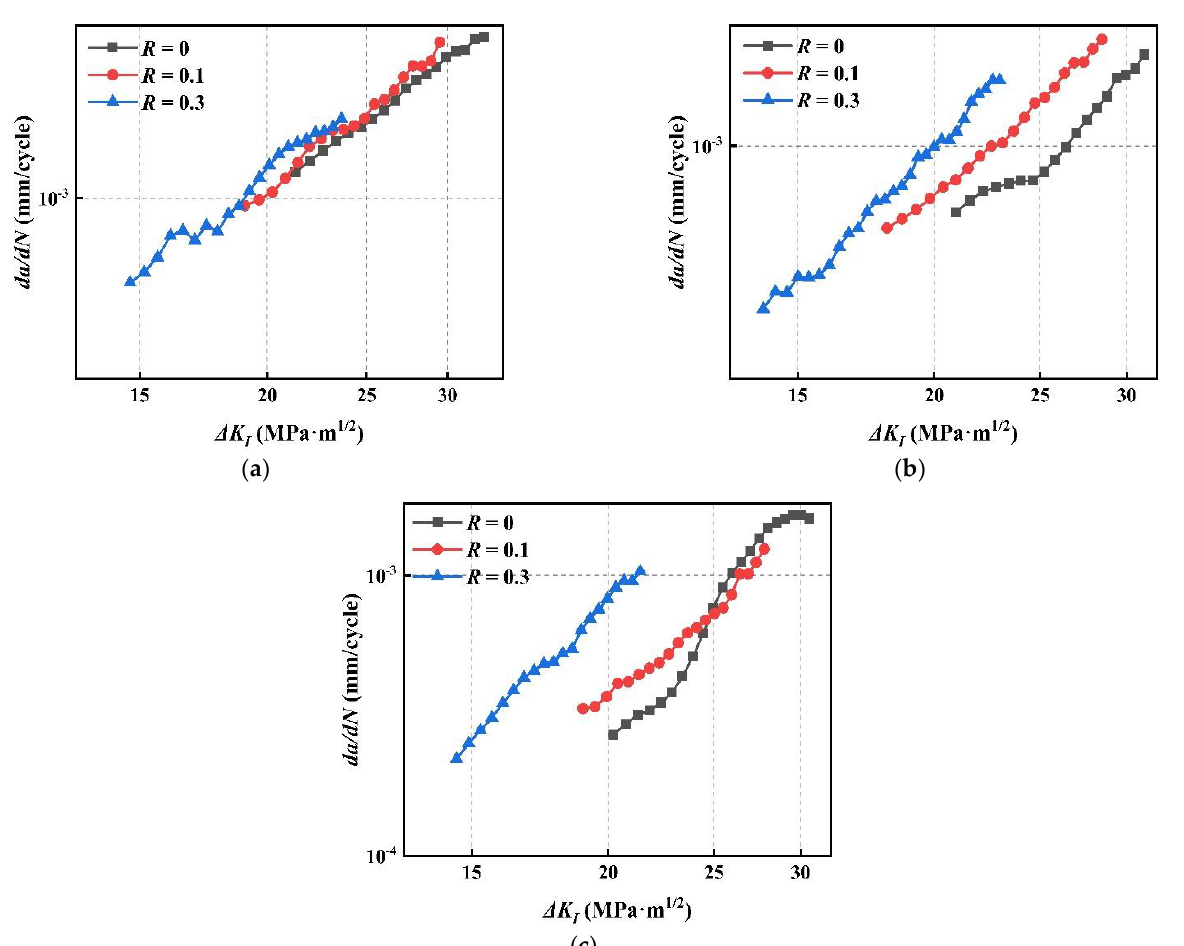
Figure 9. Wher e β = 60°, the relationship between FCGR and ∆ K I under different biaxial load ratios Figure 9. Where β = 60 ◦ , the relationship between FCGR and ∆ K I under different biaxial load ratios ( a ) λ = 0 ( b ) λ = 0.5 ( c ) λ = 1. ( a ) λ = 0 ( b ) λ = 0.5 ( c ) λ =